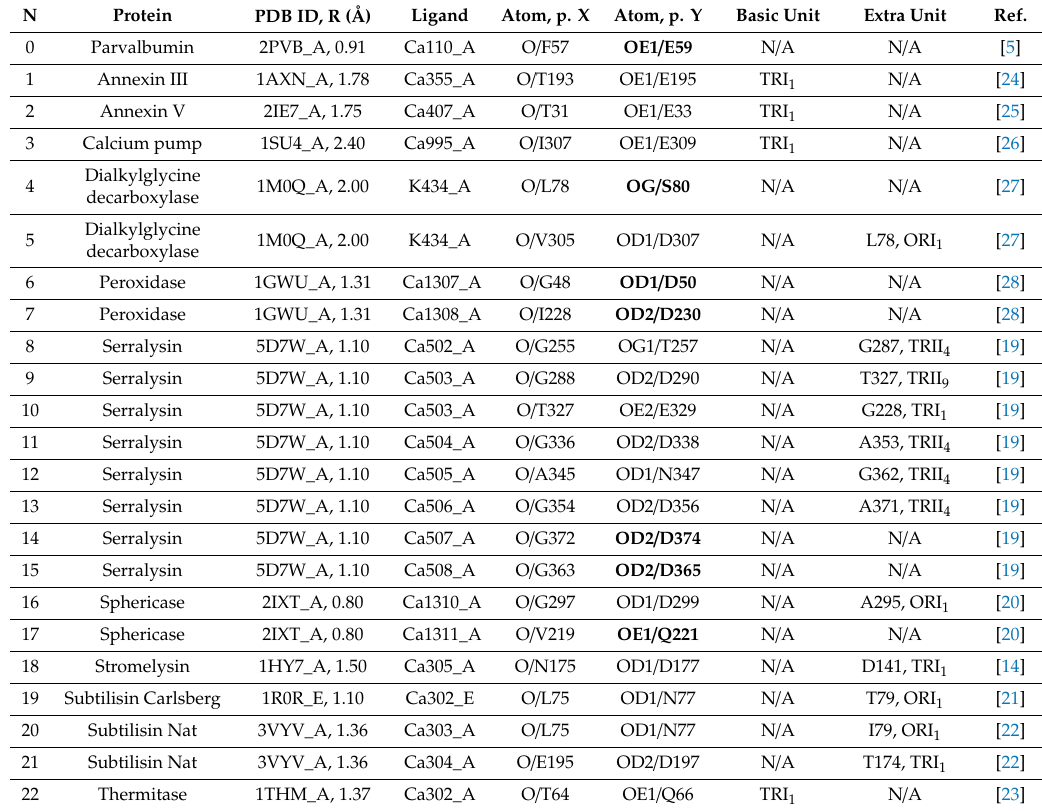
Table 2. Existence of the Clamp n,(n + 2) unit in the metal cation-binding sites of proteins with “niche” motifs in these